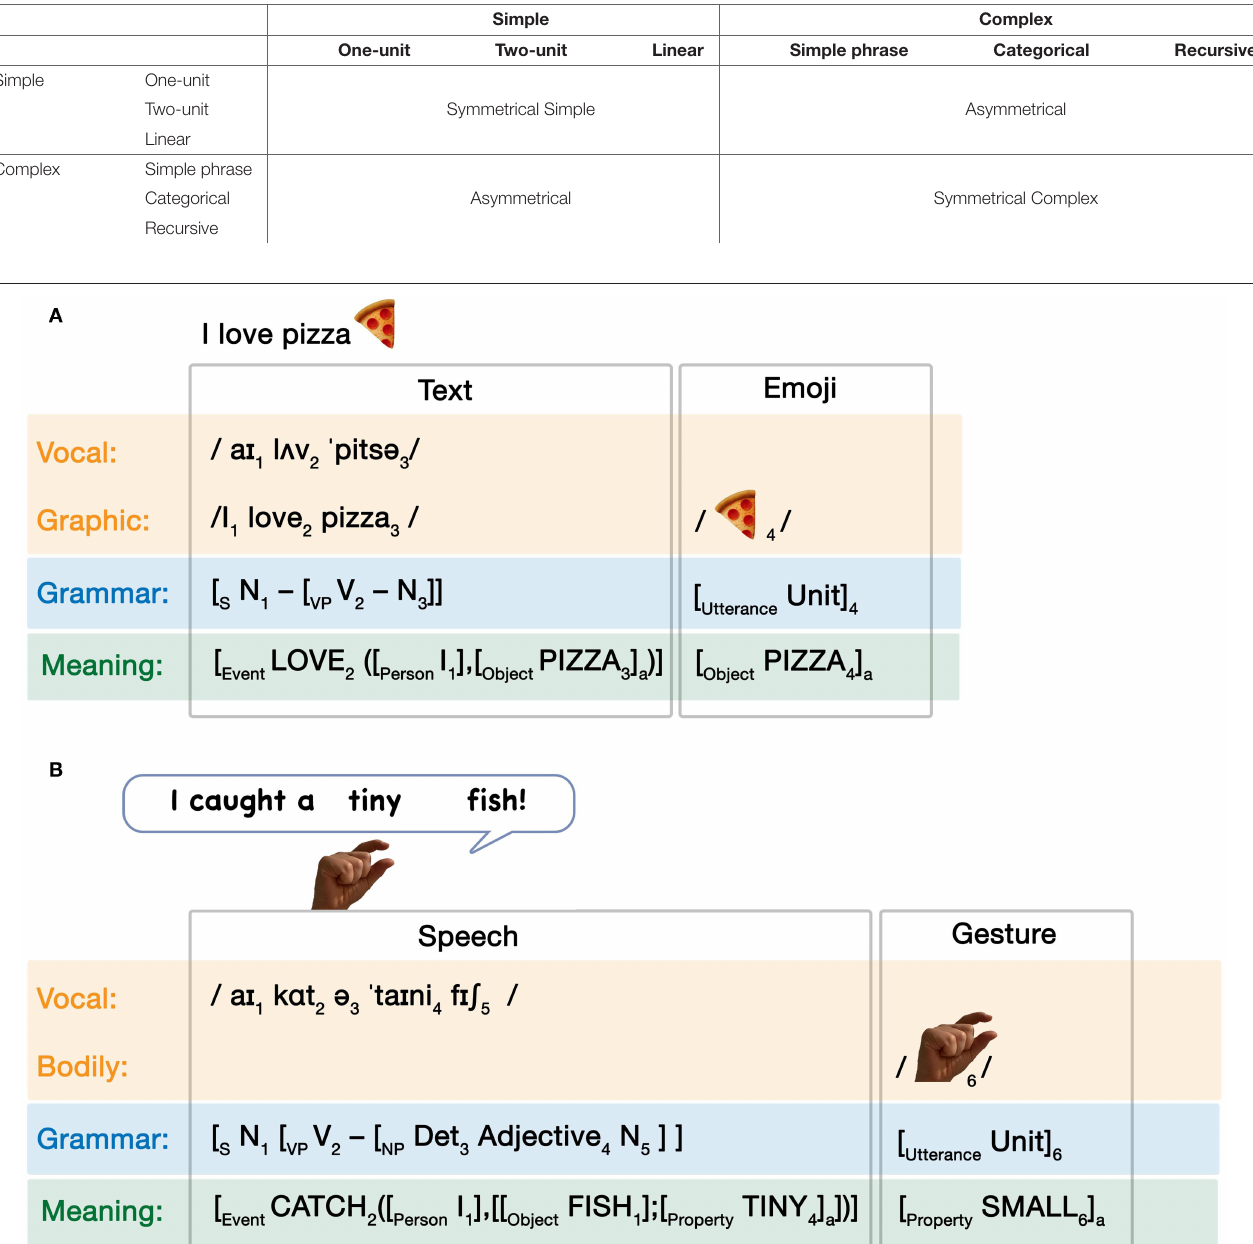
TABLE 2 | Possibilities for multimodal interactions between grammars of two modalities.